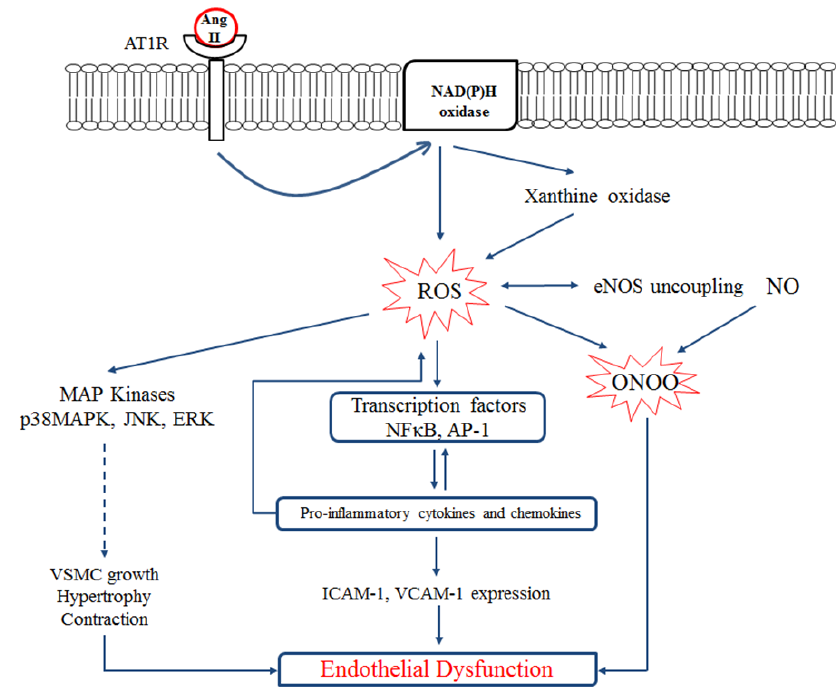
Figure 1. Interplay between the renin-angiotensin system (RAS), oxidative stress, inflammation, and endothelial dysfunction. Ang II induces reactive oxygen species (ROS) production by activating endothelial NAD(P)H oxidase through the AT1 receptor. NAD(P)H oxidase activation further increases endothelial xanthine oxidase-mediated superoxide production and oxidative stress in the endothelium. ROS activates inflammatory transcription factors which enhance expression of adhesion molecules (ICAM-1 and VCAM-1) and/or activates MAP kinases which eventually leads to the VSMC growth and contraction and endothelial dysfunction. On the other hand, ROS induces eNOS uncoupling. NO reacts with superoxide anion resulting in peroxynitrite (ONOO−) formation which also mediates endothelial dysfunction. VSMC, vascular smooth muscle cell; ICAM-1, intracellular cells adhesion molecule 1; VCAM-1, vascular cell adhesion molecule 1. Figure is drawn based on [47].